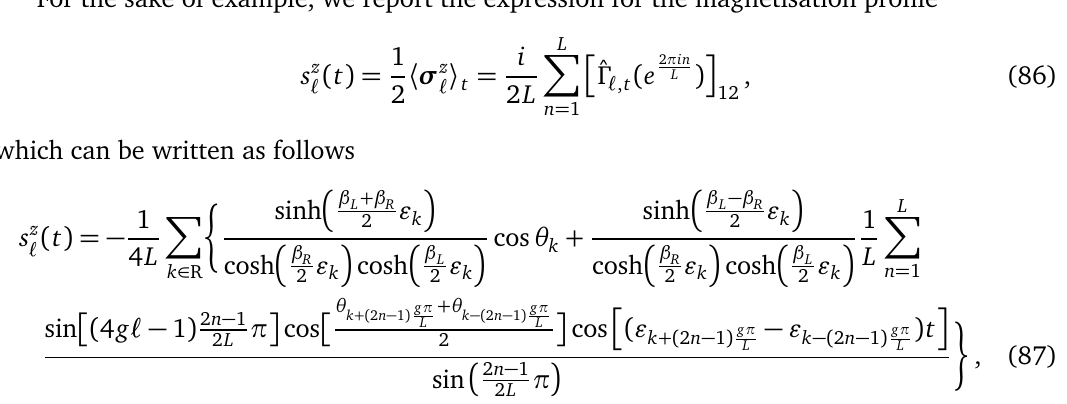
Figure 1: The profile of the local magnetisation s z spins with periodic boundary conditions on the Jordan-Wigner fermions. The system is prepared in the 4-partite LQSS at temperatures { β = 2 J − 1 ( g = 2 in (87)). Time evolution is generated by the Hamiltonian and β R (cid:80) L [ 1 σ y σ y − 5 σ x σ z ] (with periodic boundary conditions on the σ x − 1 H = J (cid:96) = 1 (cid:96) (cid:96) + 1 (cid:96) (cid:96) (cid:96) + 1 8 8 4 J-W